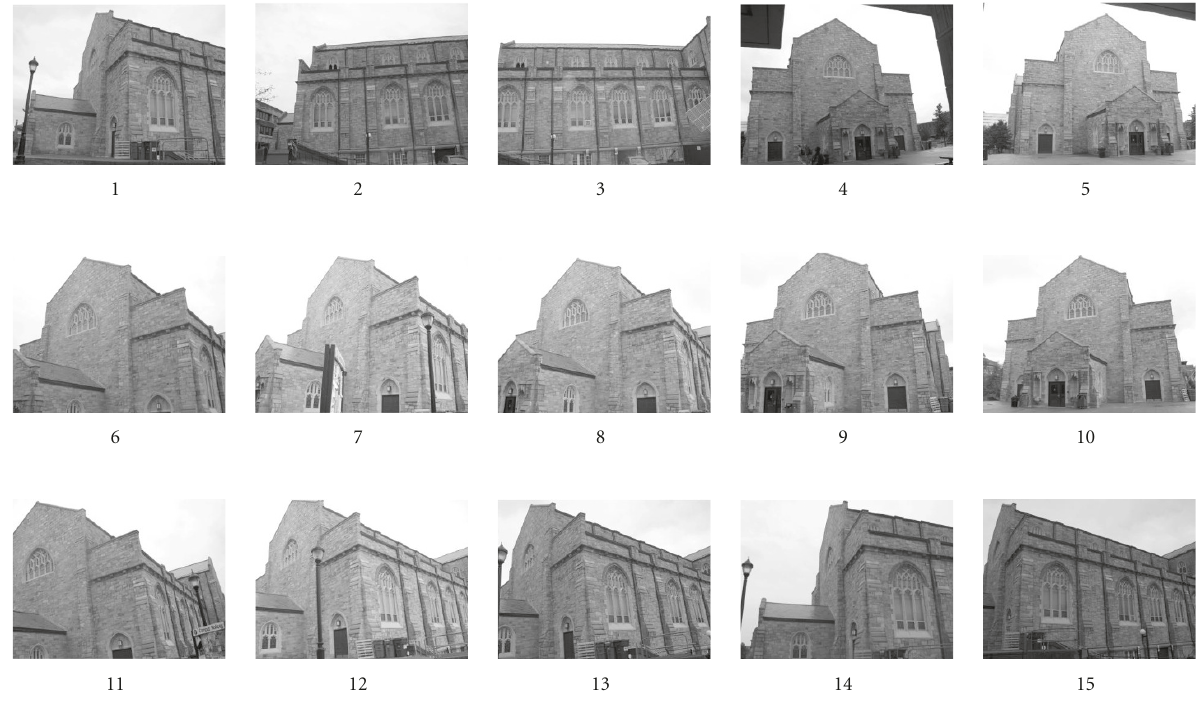
Figure 5: The 15-image data set used for the experiment on real images.